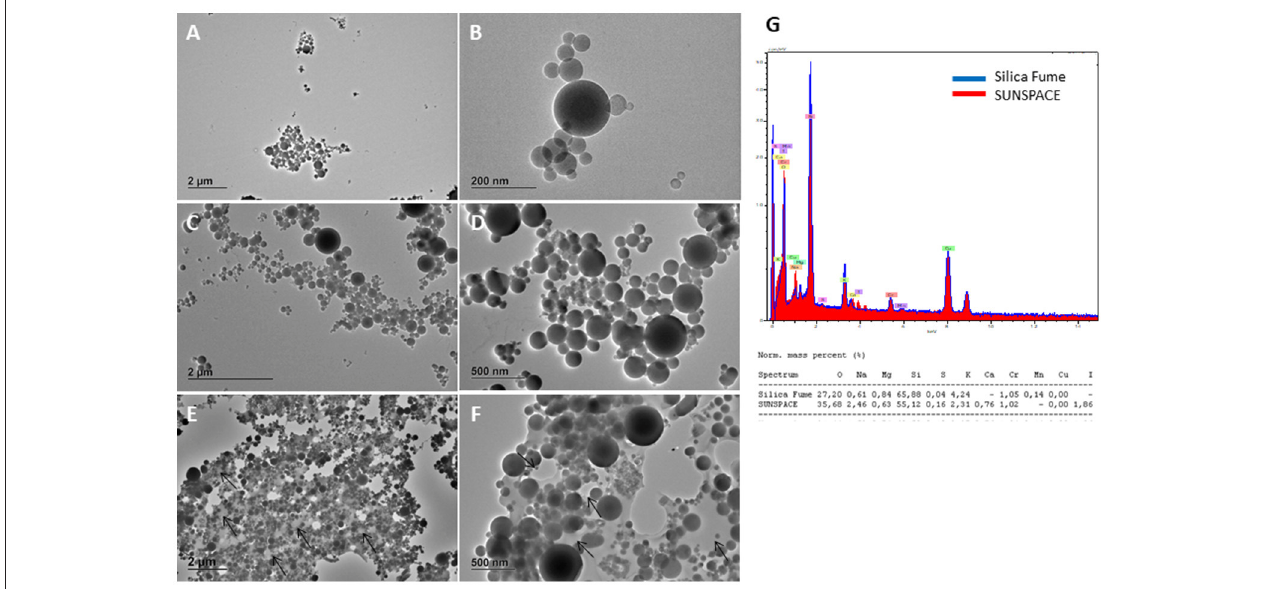
FIGURE 2 | TEM images (120 kV) of silica fume sample (A,B) SUNSPACE prepared by sonication (C,D) SUNSPACE ultrathin slices (E,F) , and EDX spectra of Silica Fume and SUNSPACE (G) . Silica fume shows particles of diameter of 20–500nm. Once embedded in epoxy resin and cut in ultrathin slices, SUNSPACE sample shows pores of 200–600nm diameter (arrows). Elemental analysis of SUNSPACE shows presence of Iodium and Calcium not measured in silica fume sample.